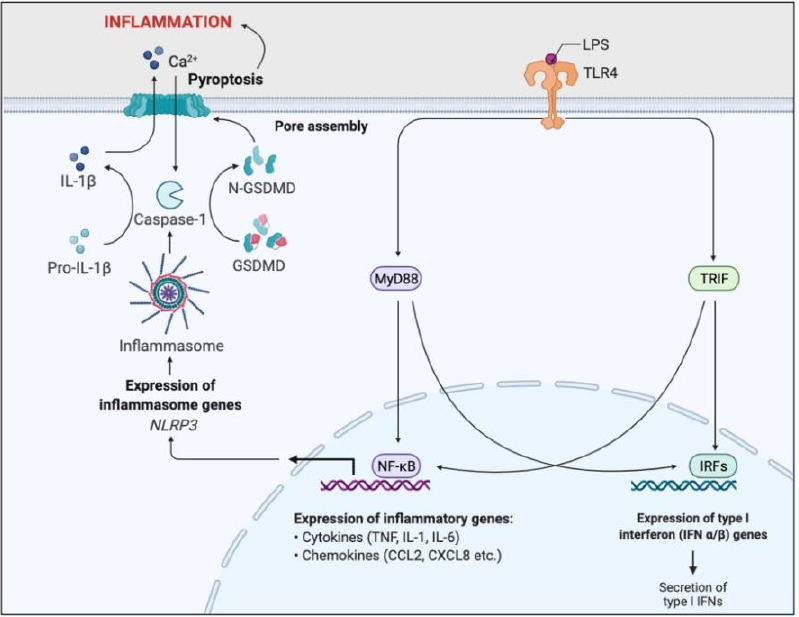
Figure 6. Simplified schematic of LPS-induced inflammatory pathway. Toll-like receptor 4 (TLR4) recognises and binds lipopolysaccharide (LPS). Binding activates two signal transduction pathways through the stimulation of myeloid differentiation primary response gene 88 (MyD88) and TIR domain-containing adaptor inducing IFN- β (TRIF) adaptor molecules. MyD88 and TRIF activates two transcription factors, nuclear factor- κ B (NF κ B) and interferon response factors (IRFs). IRFs enhance the expression of Type I interferon genes, resulting in the secretion of type I interferons. NF κ B promotes transcription of pro-inflammatory genes, such as cytokines and chemokines, resulting in acute inflammation and initiation of the adaptive immunity. NF κ B signalling also induces NOD-, LRR-, and pyrin domain–containing protein 3 (NLRP3) gene expression, essential for inflammasome formation. The NLRP3-inflammasome cleaves and activates caspase-1, which cleaves the inactive precursor pro-IL-1 β into its biologically active and secreted form, IL-1 β . IL-1 β secretion results in enhanced inflammation and immune cell infiltration. Caspase-1 also cleaves and activates Gasdermin D (GSDMD), leading to pore formation in the plasma membrane, triggering pyroptosis and further inflammation. This inflammatory pathway is a key regulator of the inflammation associated with CF.